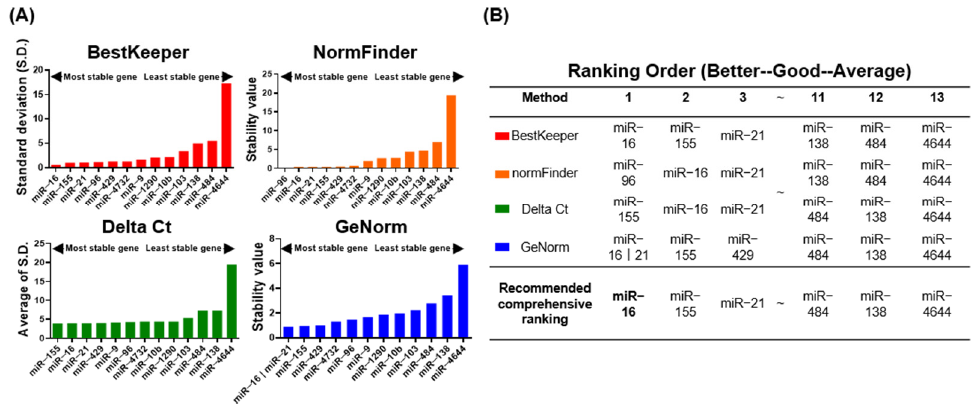
Figure 5. Selection of candidate reference genes using RefFinder. ( A ) Stability of 13 candidate miRNAs in EVs from 40 plasma samples according to Bestkeeper (red), NormFinder (orange), the Delta Ct method (green), and GeNorm (blue) statistical algorithms. ( B ) Rankings generated by RefFinder analysis. The top-ranking reference gene is shown in bold.